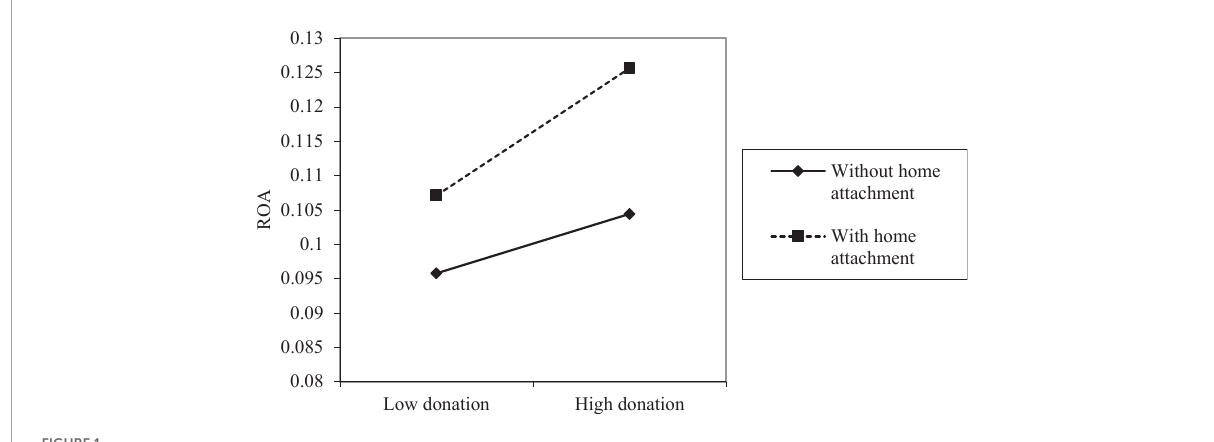
FIGURE1 Moderating effect of hometown attachment on the donation–performance relation.